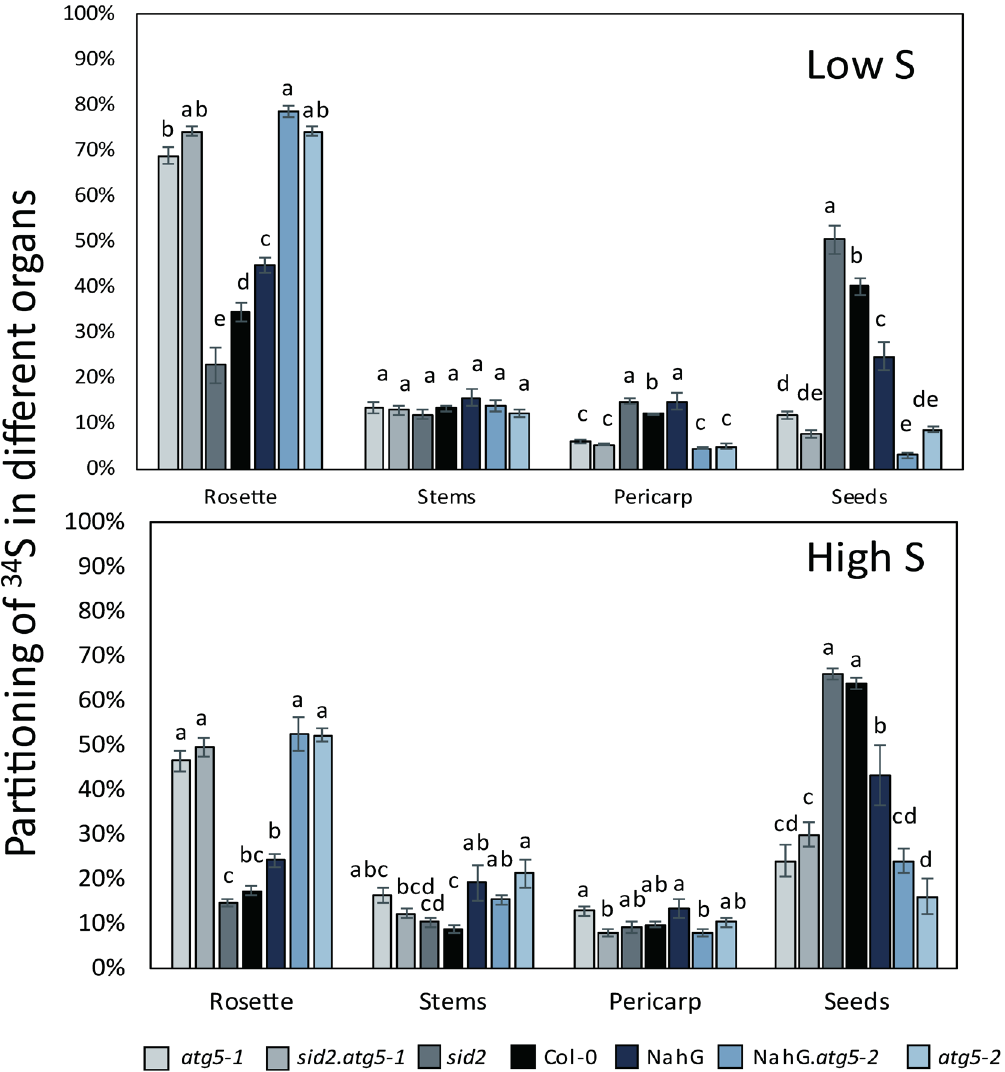
Figure 4. The partitioning of 34 S in the rosette and seeds of atg5 autophagy mutants was significantly different from that of the control lines under both low S and high S. The partitioning of 34 S in each organ was calculated as the % of 34 S in each organ relative to the total quantity of 34 S in the whole plant (see material and methods and supplemental Figure S1). Data are the adjusted means and SD from two biological repeats with six plants each. The different letters indicate values significantly different at p < 0.05 (n = 12), as determined using an ANOVA Newman–Keuls (SNK) comparison.